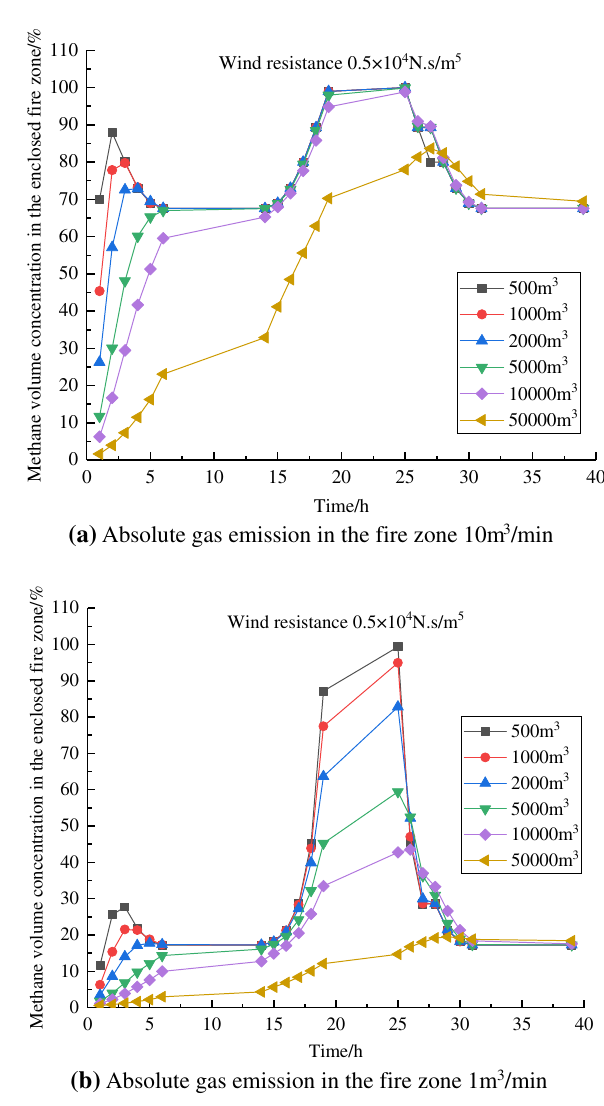
(b) Absolute gas emission in the fire zone 1m 3 /min Fig. 12 The gas concentration in different fire zones, the volume of different fire zones, and the small wind resistance. The changes of gas concentration in the fire zone with time after the completion of sealing at